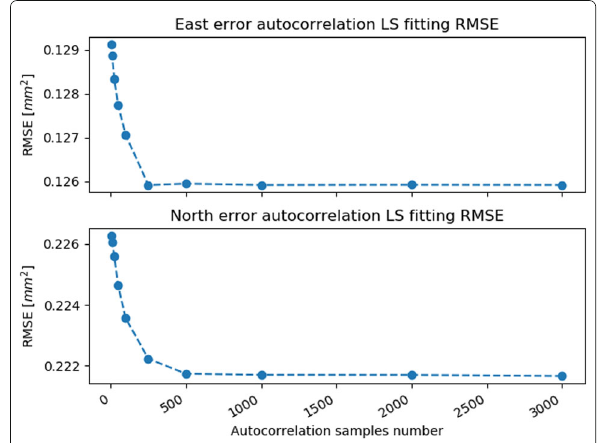
Fig. 11 Dependence between number of utilized autocorrelation function samples used for GM process fitting and the resultant RMSE